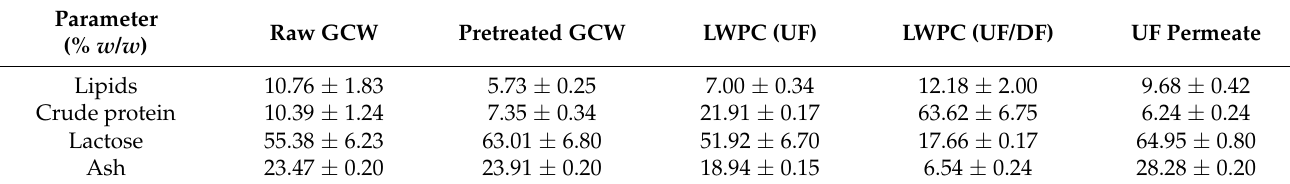
Table 2. Physicochemical characterization of samples from Goat cheese whey (GCW) (dry basis). Parameter Raw GCW Pretreated GCW (% w / w ) Lipids Crude